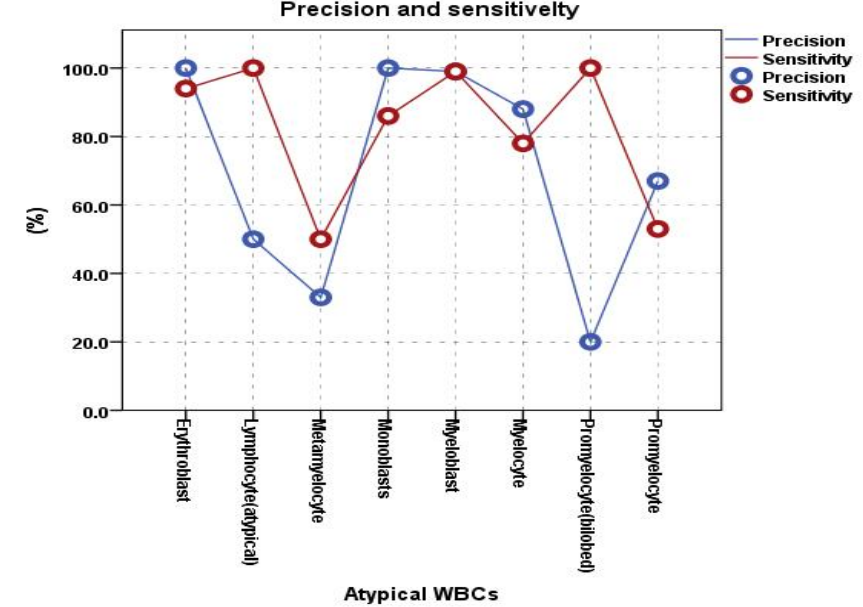
Figure 12. Precision and sensitivity of the Stage II DCAE-CNN.